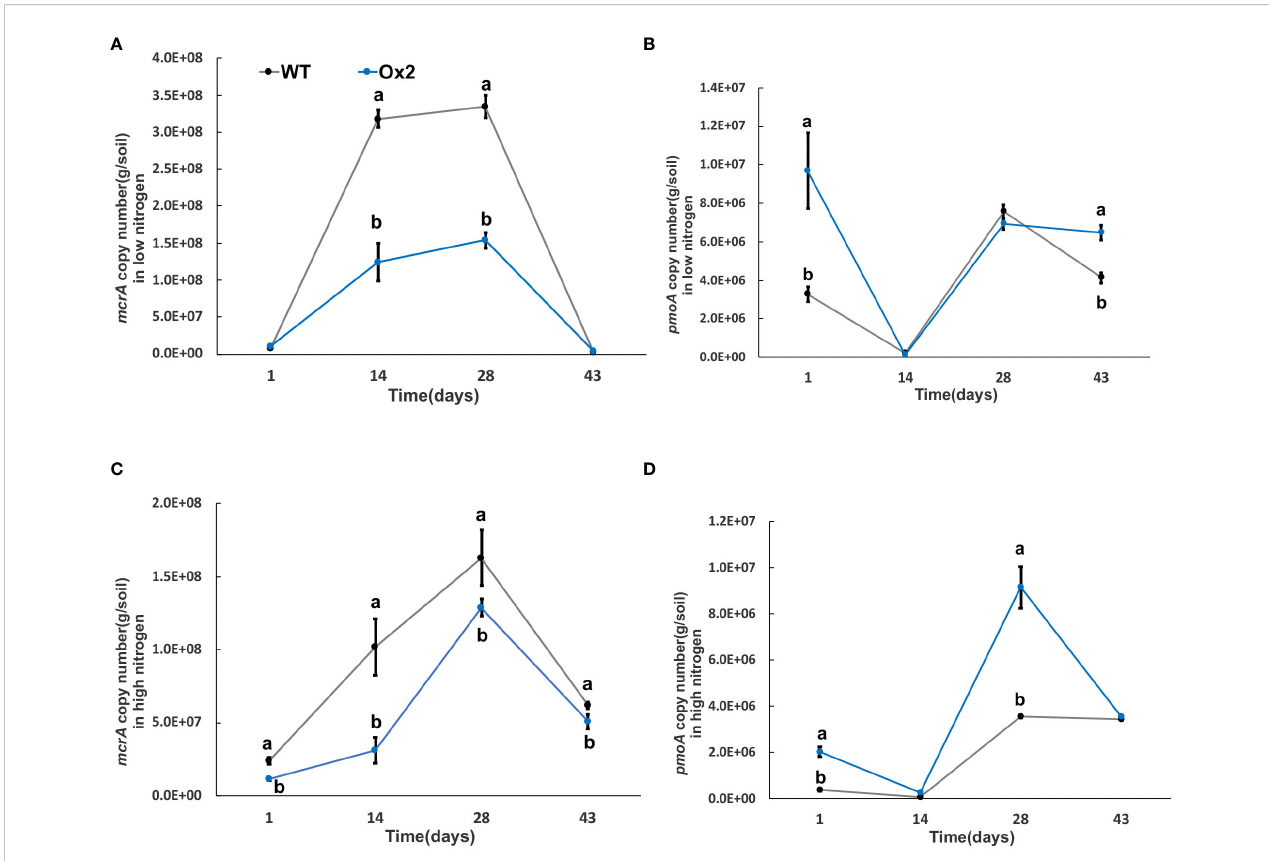
FIGURE 6 The abundance of mcrA and pmoA genes in low and high Nitrogen soil of WT and Ox2. X-axis shows the soil sampling time (days), from the fi rst measurement after transplanting seedlings from nursery to fi eld. Figures (A, C) show the mcrA copy number/g of soil. Figures (B, D) show the pmoA copy number/g of soil. Error bars: SE (n = 3). Signi fi cant difference between WT and Ox2 are indicated by different letters: a= high value, b= lower value ( t -test, p<